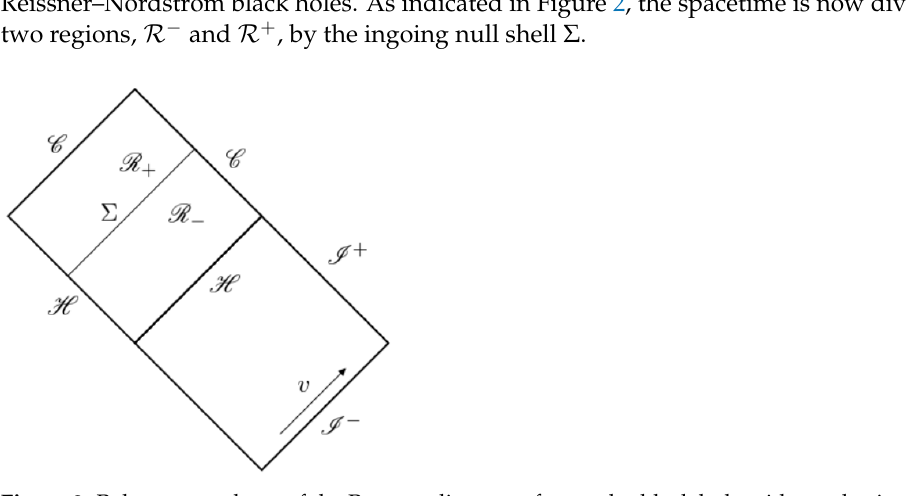
Figure 2. Relevant quadrant of the Penrose diagram of a regular black hole with two horizons.